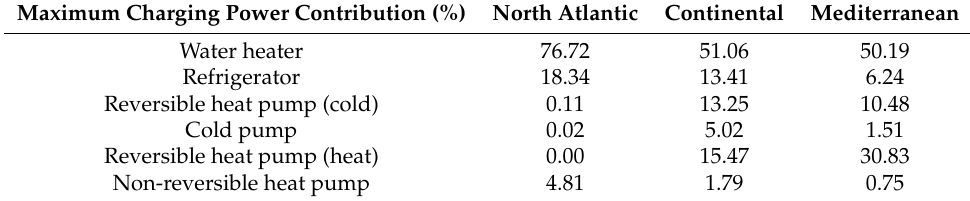
Table 8. Contribution percentage of each type of TCL to maximum charging power per climate area in 2019.